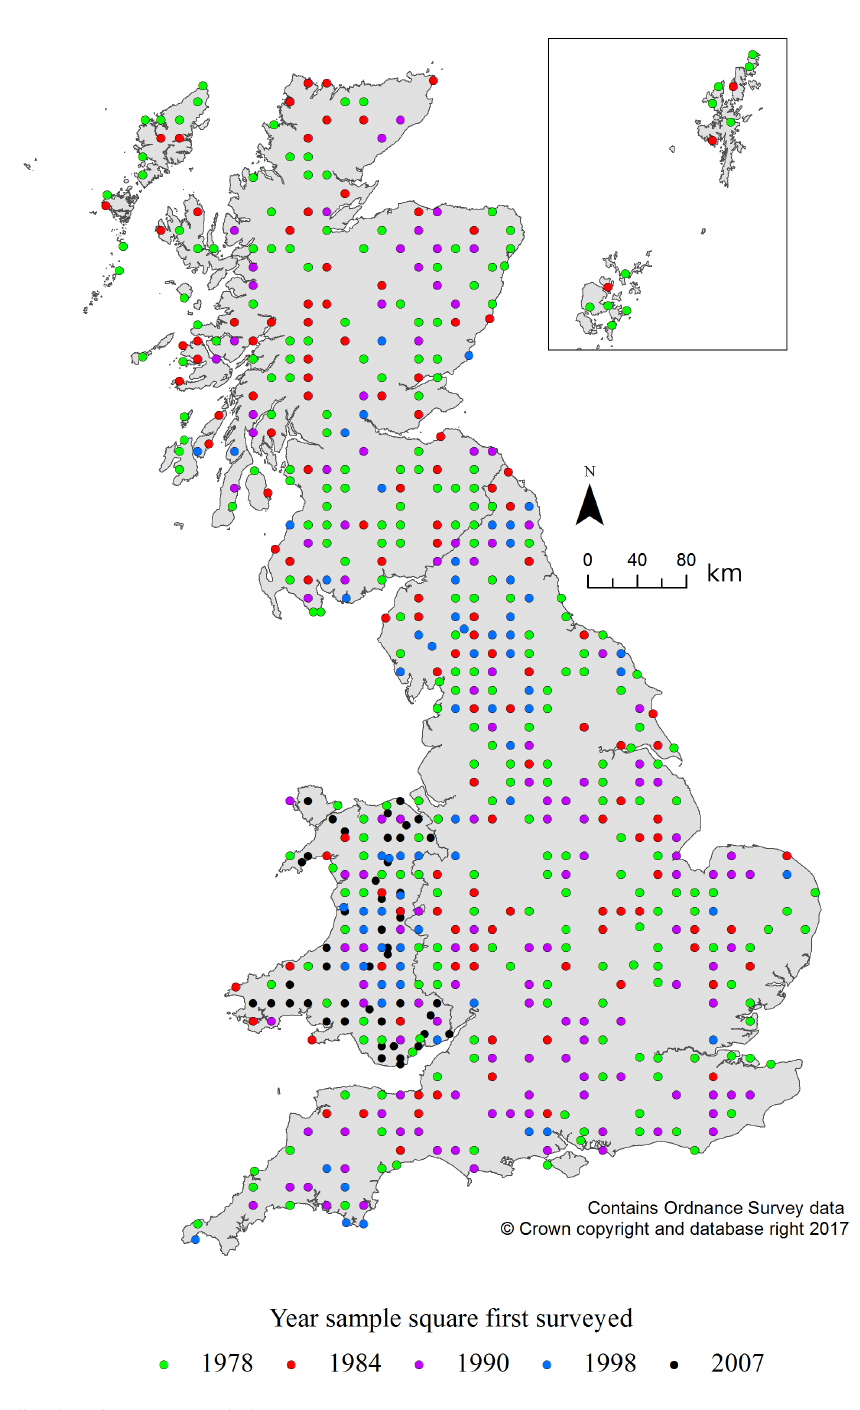
Figure 1. Map of sampling locations across